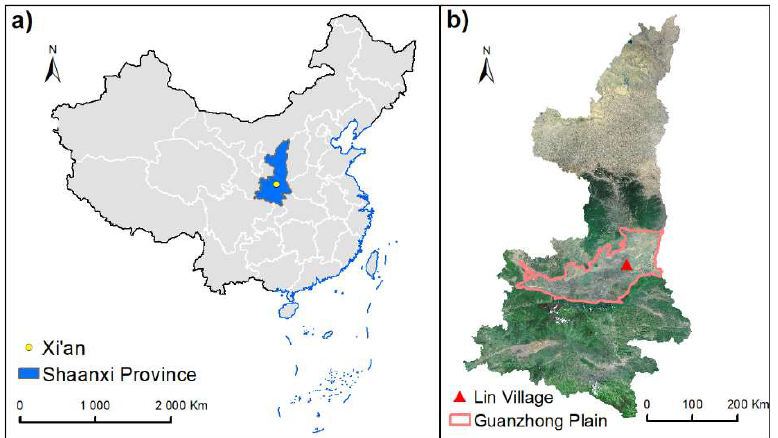
Figure 1. Location of the sampling site in a rural area of Guanzhong Plain, Northwest China. ( a ) Map of China, ( b ) Sampling point location of Guanzhong Plain.